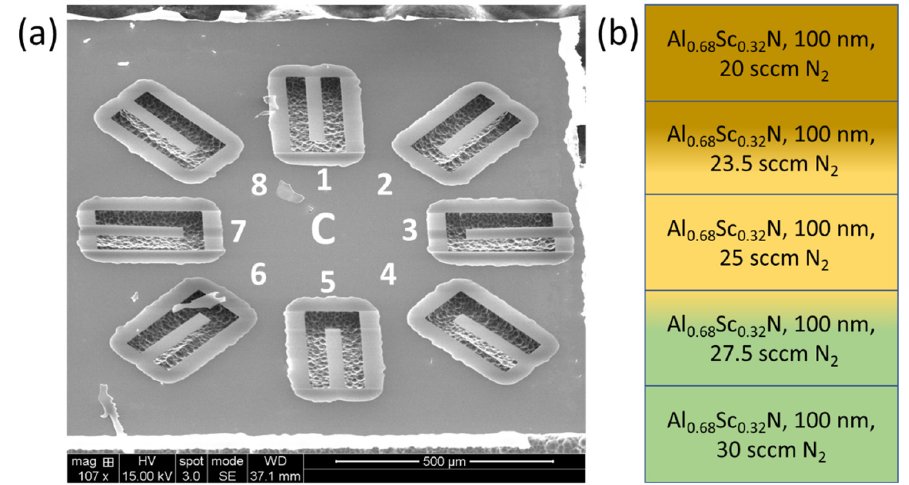
Figure 6. Graphics for multi-layer 500 nm PVD sputter-deposited Al 0.68 Sc 0.32 N film, ( a ) 45-degree SEM image of the center die (C) fabricated from a 100 mm wafer. ( b ) Stack-up with five equal thickness layers with different N 2 process gas flows to compensate for the through-thickness stress gradient. Table 3. Cantilever tip deflection for a die near the center of a 500 nm Al 0.68 Sc 0.32 N film with AlN and Sc gradient (Al 1 → 0.68 Sc 0 → 0.32 N) seed layers.